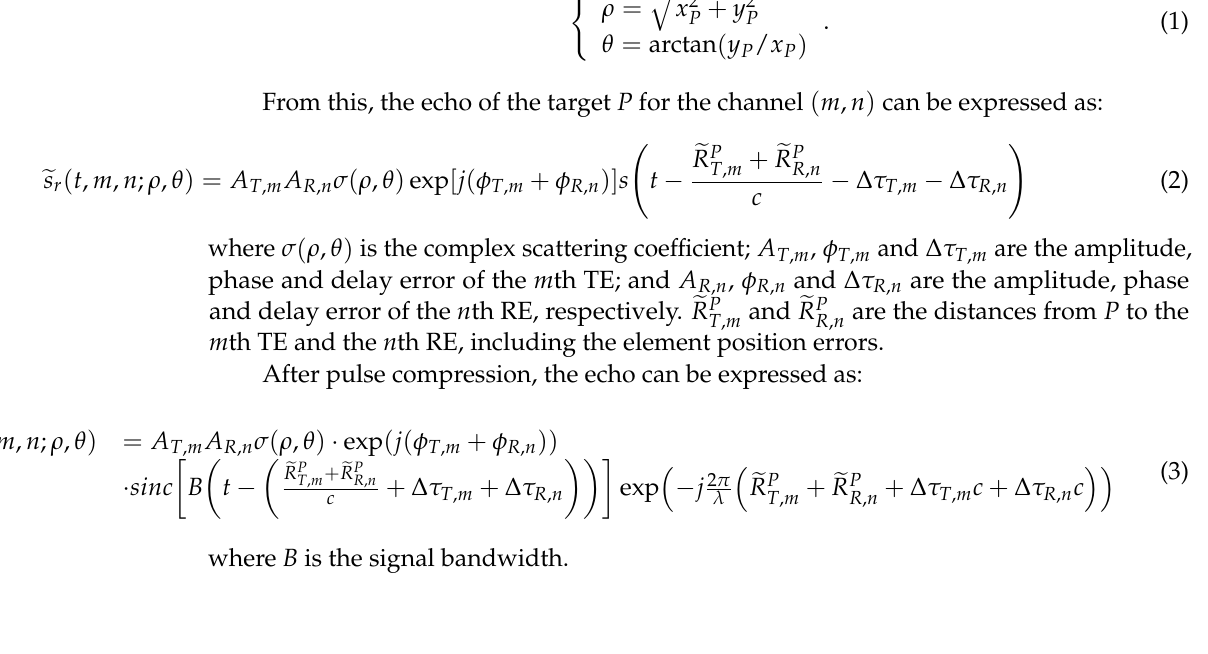
( ) , x y in the Cartesian coordinate system, and at P P